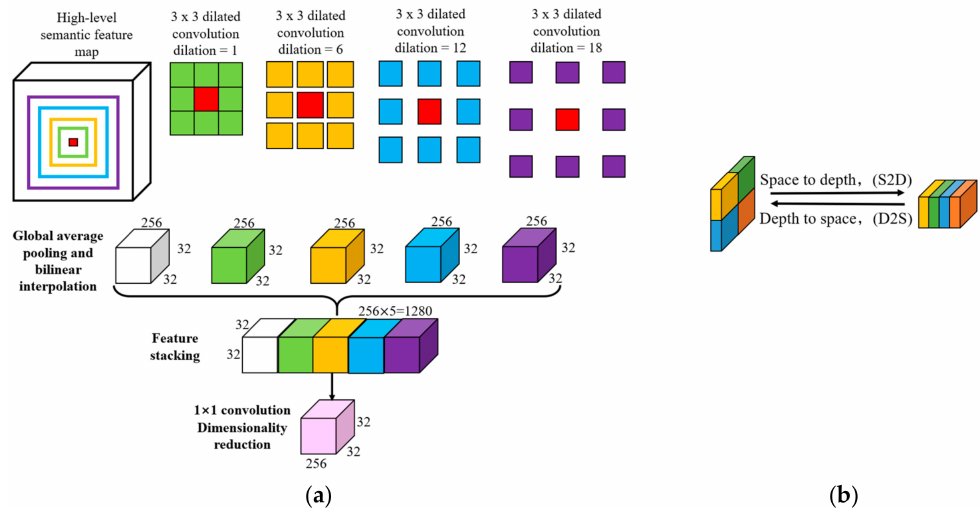
Figure 3. Network modules: ( a ) Atrous Spatial Pyramid Pooling (ASPP) module in DeeperLabC; ( b ) S2D and D2S transformation of the feature map.